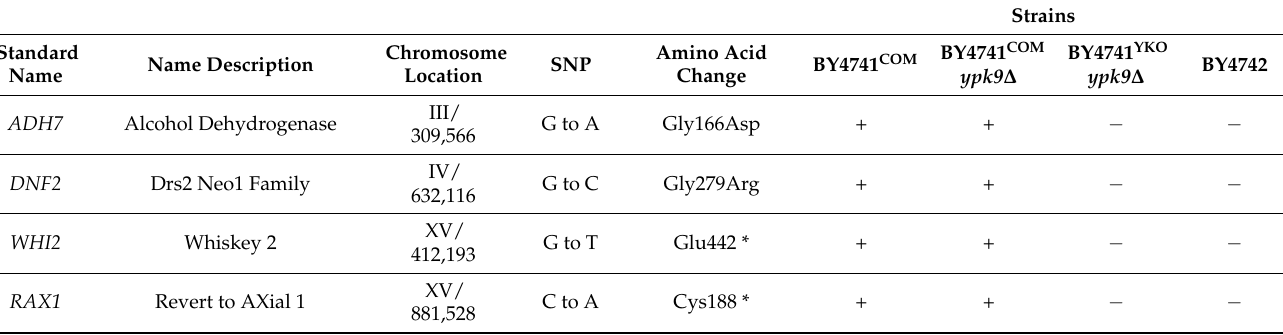
Table 1. SNPs within ORFs determined by whole-genome sequencing.